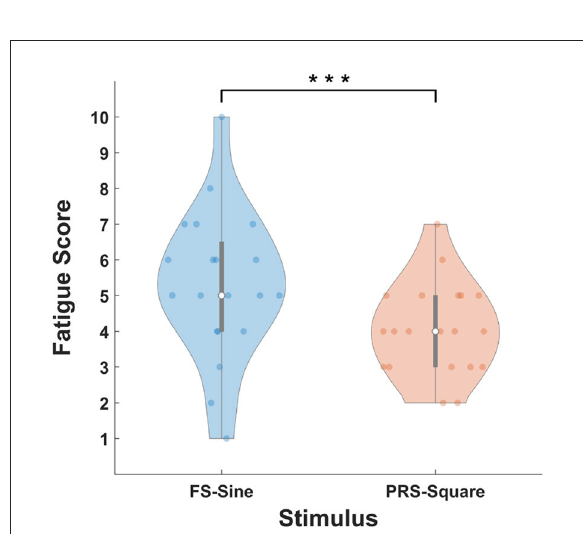
FIGURE12 Average fatigue scores for FS-Sine and PRS-Square. Gray bars represent the interquartile range from 25 to 75% and white circles indicate the median values. Here, the asterisk of *** represents p < 0.005 (Wilcoxon signed-rank